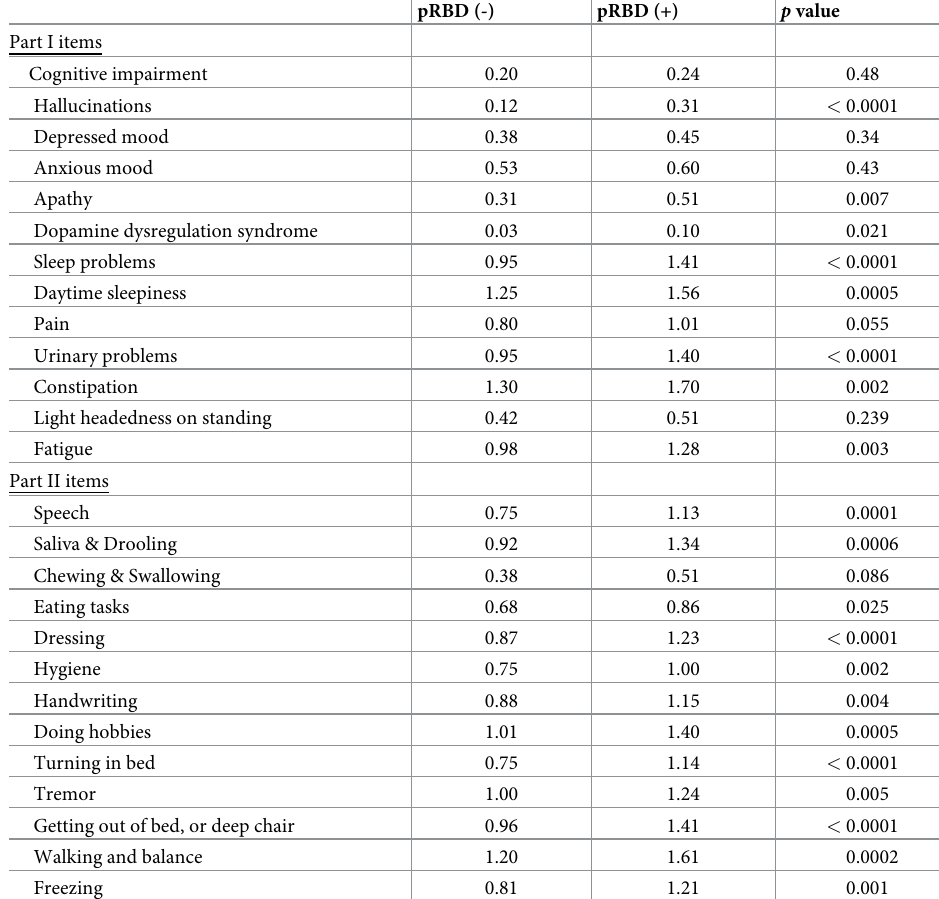
Total scores on MDS-UPDRS parts I–III and the LED were significantly higher in the pRBD (+) than in the pRBD (–) group. Previous studies have reported that scores on the MDS-UPDRS parts II–IV were higher in PD with pRBD than without RBD [11], and drug- na ï ve patients with early PD with RBD had higher scores on MDS-UPDRS parts I and II than did patients with PD without RBD [19]. Among the non-motor symptoms on MDS-UPDRS part I, VHs and apathy were related to pRBD in this study. An association between VHs and RBD in patients with PD has been reported in numerous studies [11, 19, 20, 22]. Liu et al. [20] compared the clinical symptoms of PD with and without RBD with RBDSQ cutoff values of 5, 6, and 7 points. A significant difference in VHs was observed between the two groups at a cut- off of 6 points and above, but not at a cutoff value of 5 points. In addition, the present study revealed that VHs, sleep problems, and daytime sleepiness on MDS-UPDRS part I affected the RBDSQ-J scores. VHs, male gender, and MDS-UPDRS part II scores have been reported to be contributing factors to pRBD in patients with PD [11]. Although there are few reports about the relationship between apathy and RBD, more severe apathy symptoms were recently reported in patients with PD with than without RBD, independent of age and years [34].